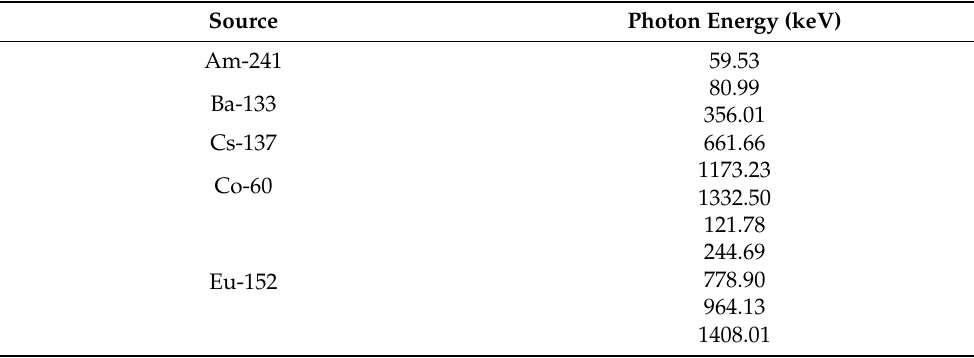
Table 3. Standard radioactive point source